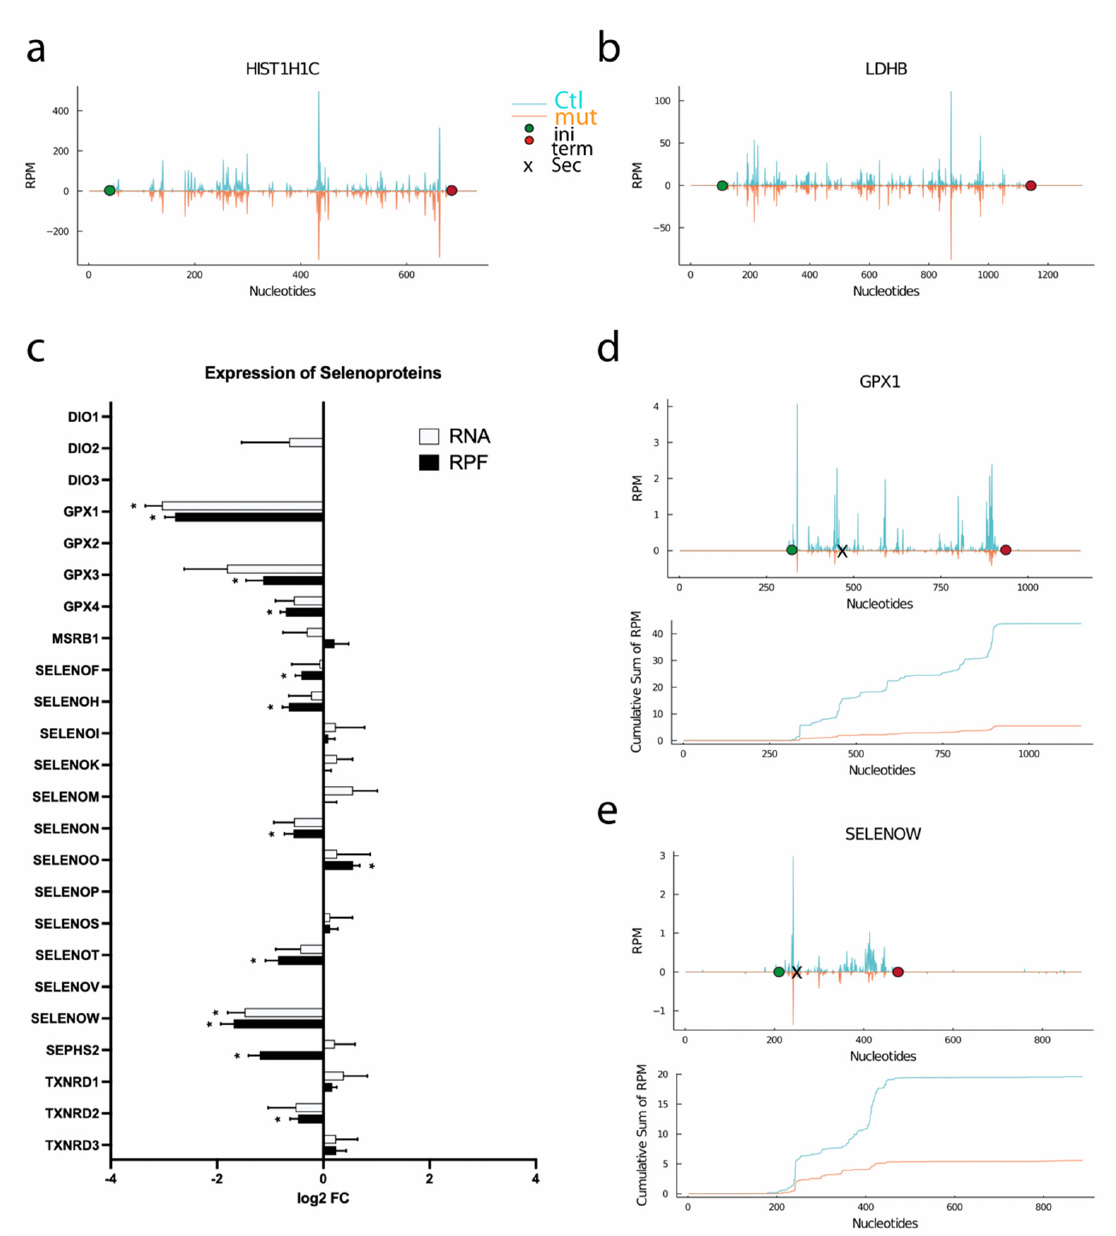
Figure 2. Ribosomal profiling in SECISBP2 -mutant HAP1 cells. ( a ) Unrelated control gene HIST1H1C . ( b ) Unrelated control gene LDHB . RPM reads per million mapped reads. ( c ) Comparison of total RNA (from 3 ′ RNA-Seq) and RPF (ribosomal protected fragments) counts in SECISBP2 -mutant vs. Ctl cells. FC = fold-change. * q < 0.05. Benjamini–Hochberg correction, N = 2. ( d , e ) Ribosomal coverage on GPX1 and SELENOW mRNA. The mean values of the genotypes were plotted. The position of the UGA/Sec codon is marked by “ × ”. Start and Stop positions are marked as green and red circles. Cumulative sums of RPF are shown below the corresponding profiles. Ctl, blue; SECISBP2 -mutant, orange.